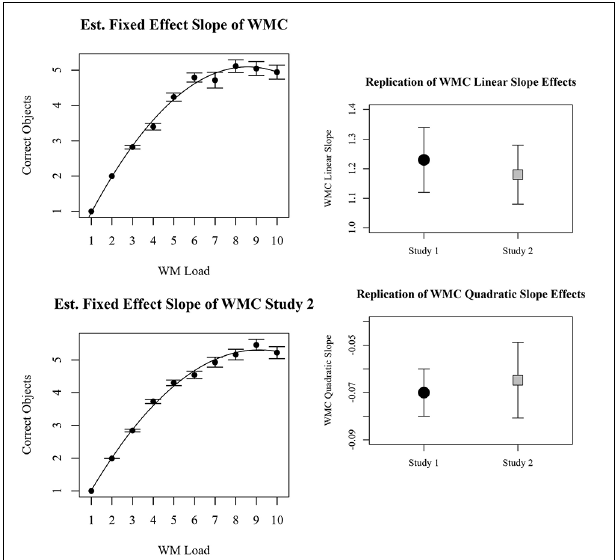
FIGURE 4 | Plots on the left represent behavioral results for the number of objects reported correctly for each memory load. Results from study 1 are top left, results from study 2 are bottom left. Beta coefficients and 95% confidence intervals of linear and quadratic slopes for correctly reported dots in study 1 and study 2 are compared on the right.